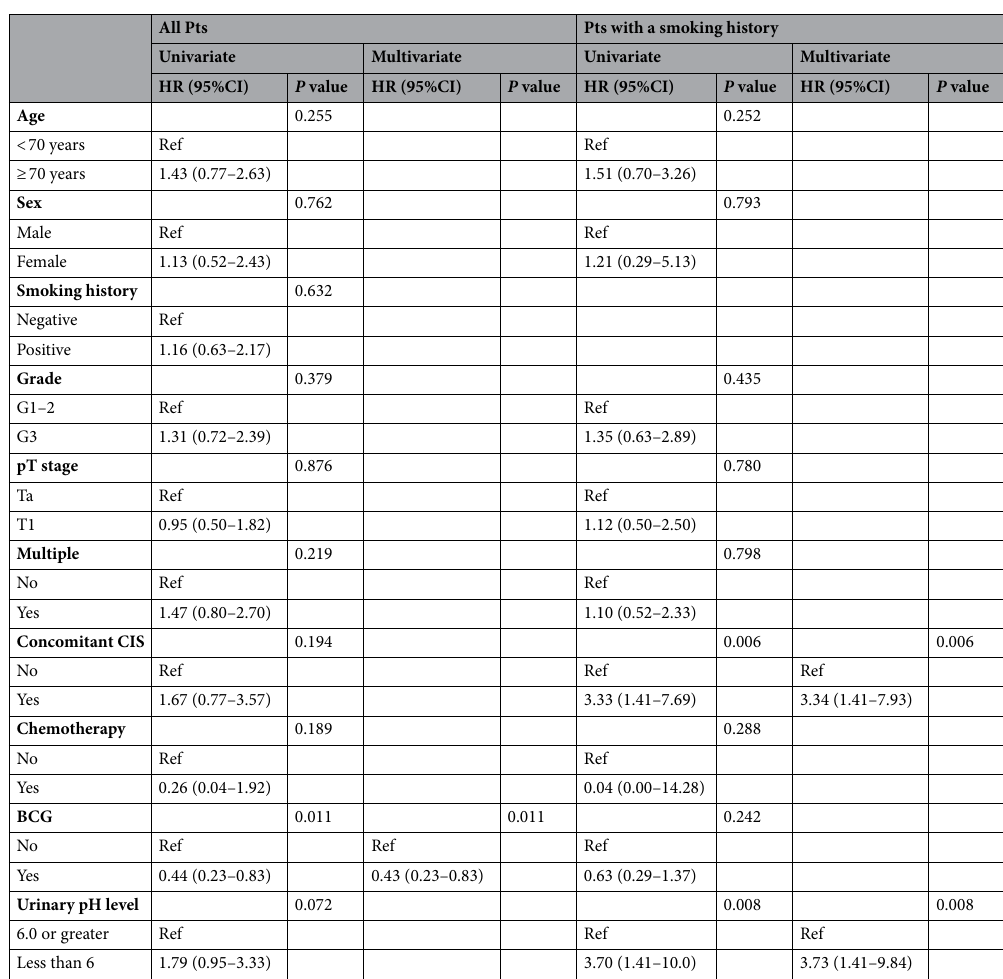
Table 2. Relationships between clinicopathological factors and upper urinary tract recurrence after TURBT in all patients and those with a smoking history. UTUC, upper urinary tract urothelial carcinoma; Pts, Patients; HR, hazard ratio; CI, confidence interval; CIS, carcinoma in situ.